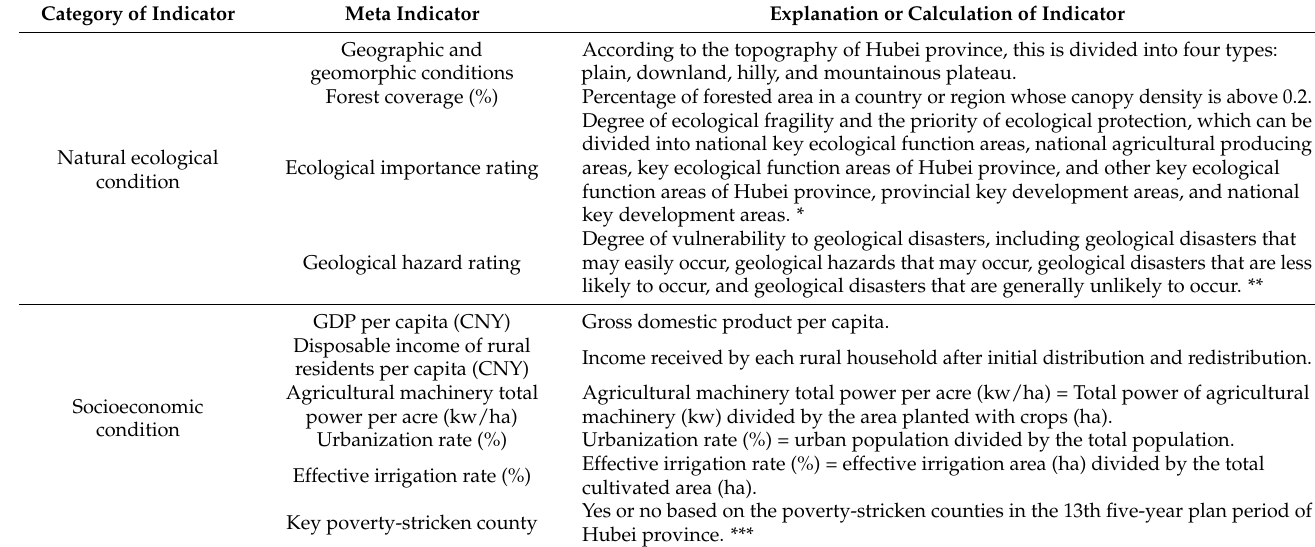
Table 1. Indicator system of land consolidation